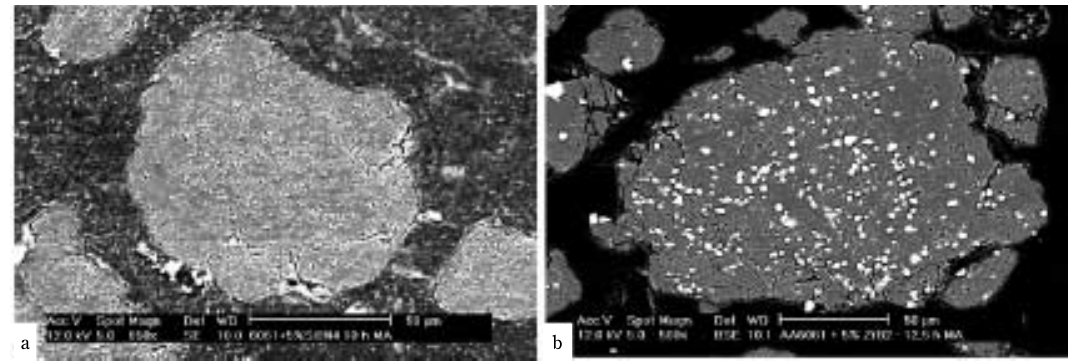
Fig. 4 Composite powders reinforced with (a) Si 3 N 4 and (b) ZrB 2 after